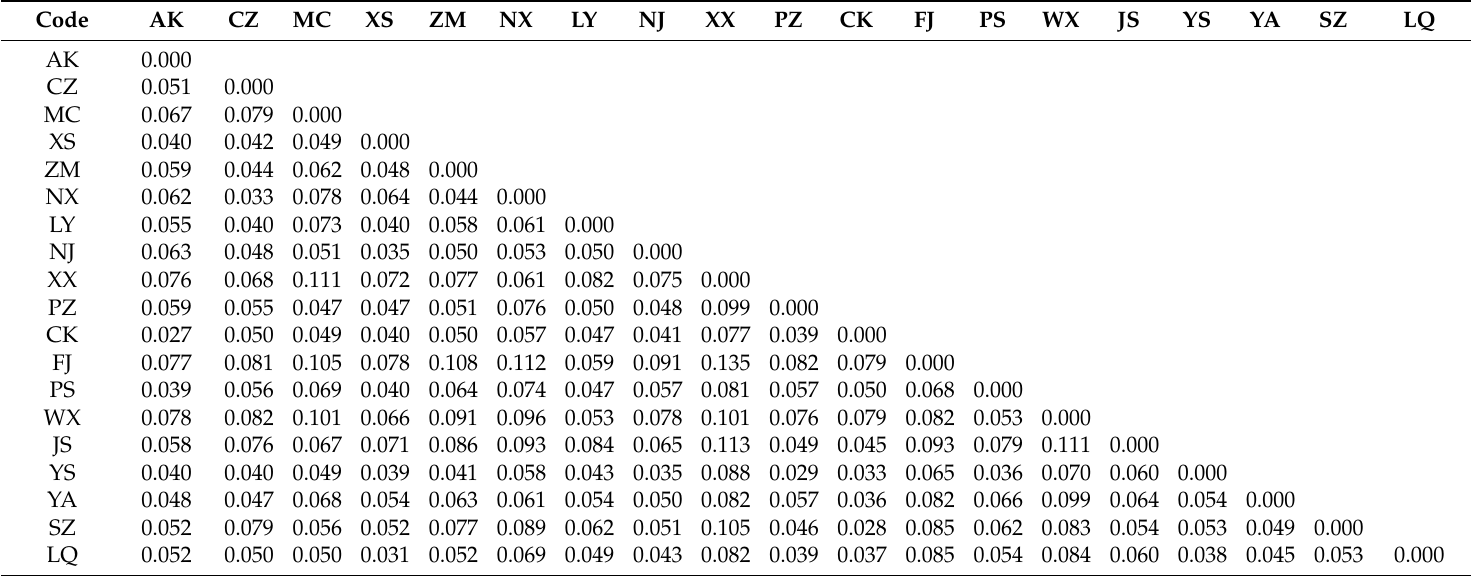
Table 4. The pairwise F ST for all populations of Q.